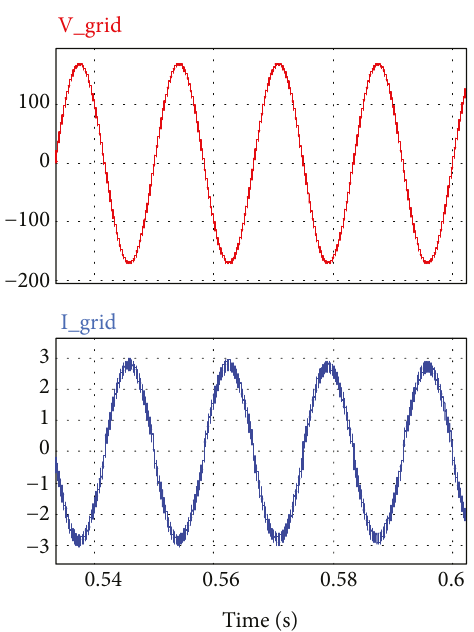
Figure 6: Topology injecting only active power. From (a) to (b): grid voltage (100V/div) and grid current (1 A/div).